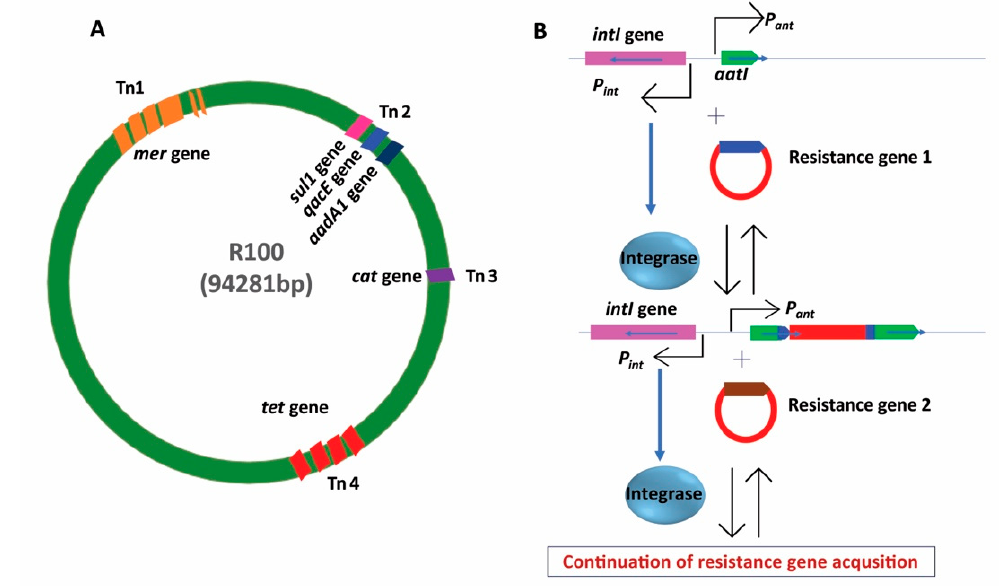
Figure 4. Trinity of horizontal resistance gene transfer modalities. Transmission of genetic material by horizontal genetic transfer, which is accomplished by three different mechanisms: transformation—bacteria take up naked DNA from the environment and integrate it to their chromosomes (1), transduction—bacteriophages carry resistance genes and transfer them to multiple hosts (2), and conjugation—resistance genes are transferred between bacterial cells through cell-to-cell contact (3).